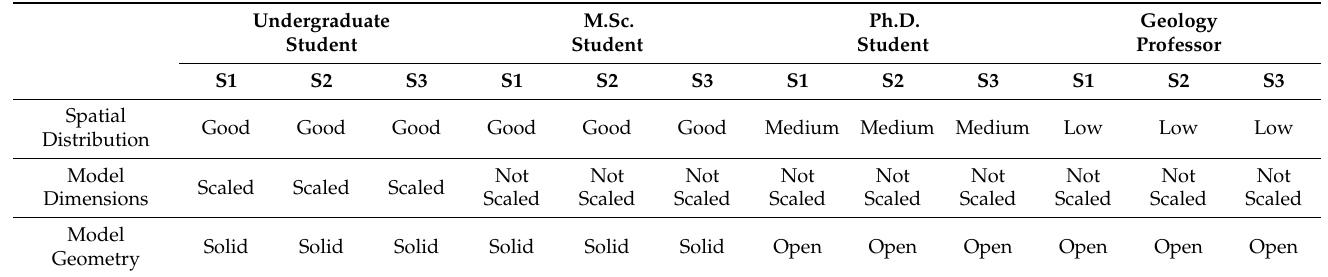
Table 5. Qualitative analysis previous to the methodological